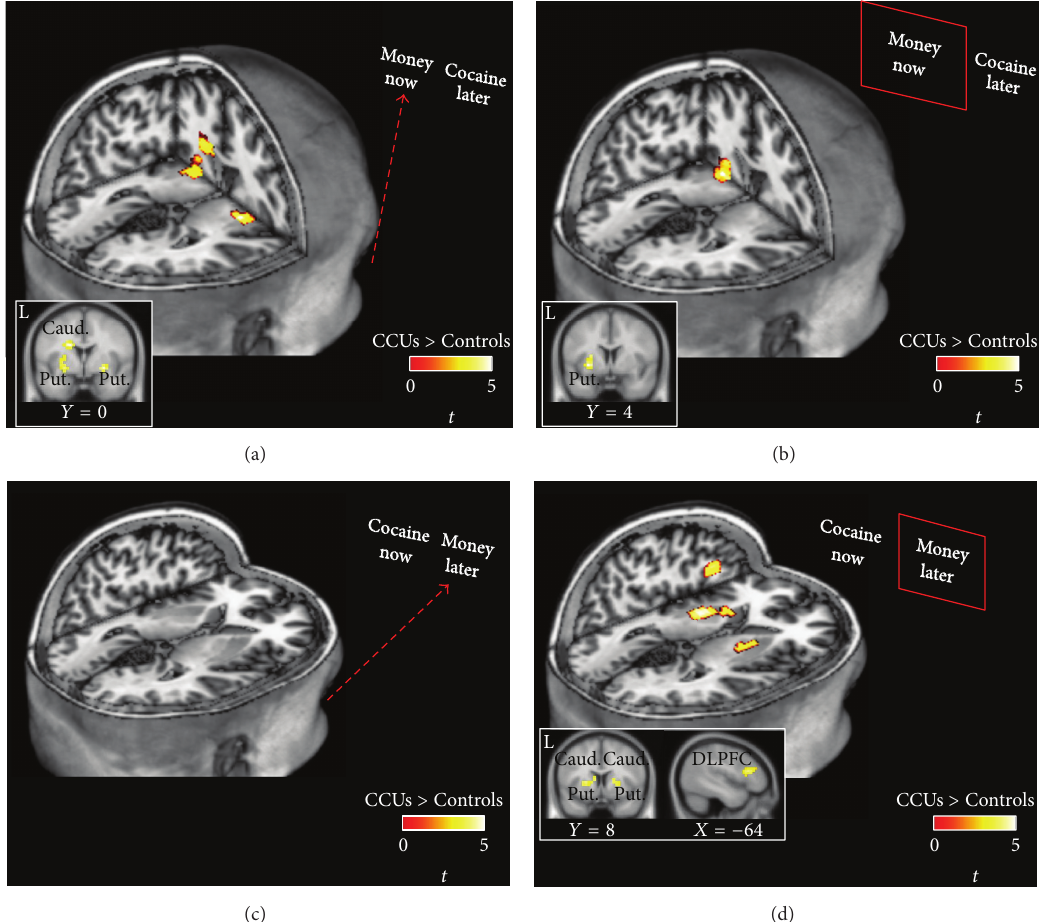
Figure 5: Chronic cocaine users choosing money instead of cocaine. Data are functional clusters where chronic cocaine users (CCUs) had greater responses than controls (Controls) for money choices in cross-commodity tasks. Choices were between immediate money and future cocaine (MC: (a), (b)) or between immediate cocaine and future money (CM: (c), (d)). Each individual’s immediate (now) and future (later) choices were used to isolate activity while viewing (dashed red line) what became money choices (a), (c) and while submitting money choices (b), (d). Activity in the striatal putamen, caudate, and globus pallidus was greater in CCUs while viewing what became money now choices (a) and while executing money later choices (d). In addition, activity in the left dorsolateral prefrontal cortex was greater for money later